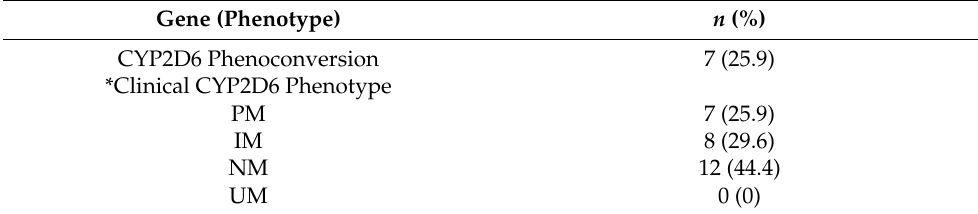
Table 4. CYP2D6 phenoconversion.